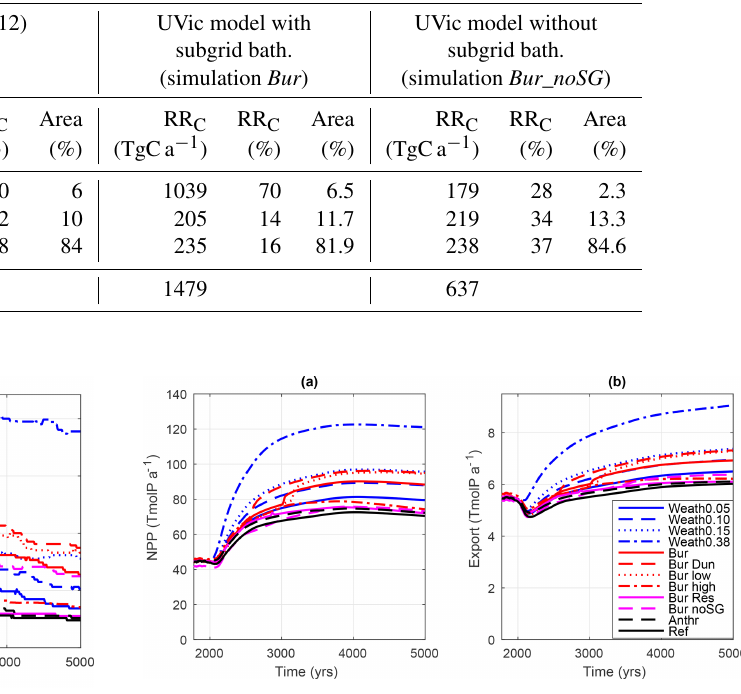
Figure 5. Globally integrated (a) suboxic volume in percentage of total ocean volume and (b) suboxic sediment surface area in per- centage of total sediment surface area. Water is designated as sub- oxic for oxygen concentrations below 5mmolO 2 m − 3 . Simulation descriptions can be found in Table 1.